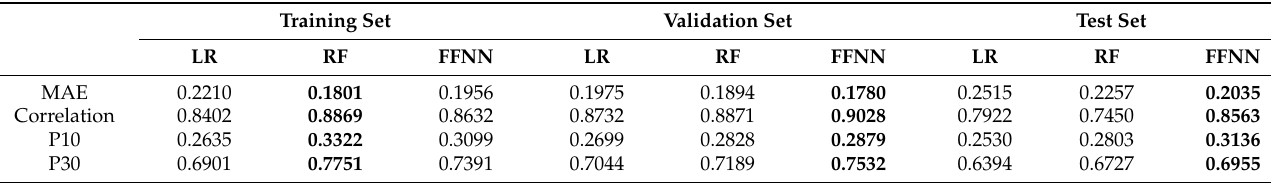
Table 2. Performance metrics for the three considered models in the training and validation sets. LR, linear regression. RF, random forest. FFNN, feed forward neural network. MAE, mean average error. Correlation, Pearson product-moment correlation coefficient. P10/P30, fraction of predictions with an error within the 10%/30% threshold. Best results for each set are highlighted in bold.